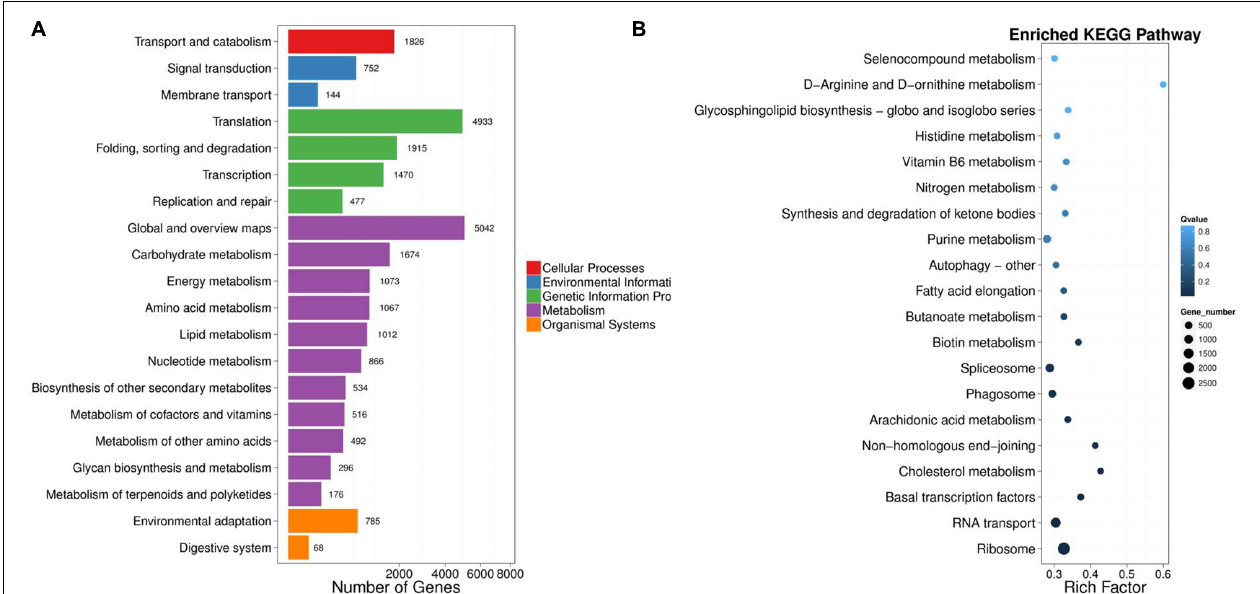
FIGURE 6 | KEGG pathway classification of differentially expressed genes in roots of NaCl-treated Puccinellia nuttalliana plants compared to the untreated control. The five branches for KEGG pathways: cellular processes, environmental information processing, genetic information processing, metabolism, organismal systems, and drug development (A) , top 20 KEGG pathways of differentially expressed genes in roots of salt treated Puccinellia nuttalliana plants compared to the controls (B) . X axis represents enrichment factor. Y axis represents pathway name. The q value is indicated by the colors (high: white, low: blue), the lower q value indicates the more significant enrichment. Point size indicate DEG number (The bigger dots refer to larger amount). Rich Factor refers to the value of enrichment factor, which is the quotient of foreground value (the number of DEGs) and background value (total Gene amount). The larger the value, the more significant